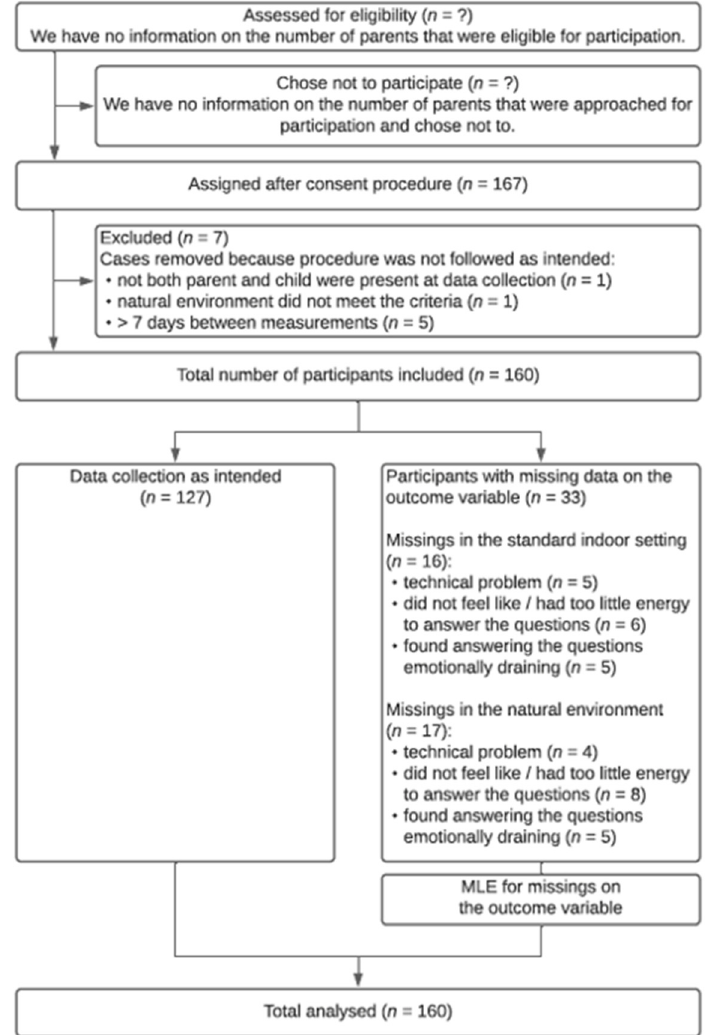
Figure 1. The flow of participants with the total number of participants in each group at each stage, and reasons for drop out. Int. J. Environ. Res. Public Health 2020 , 17 , x